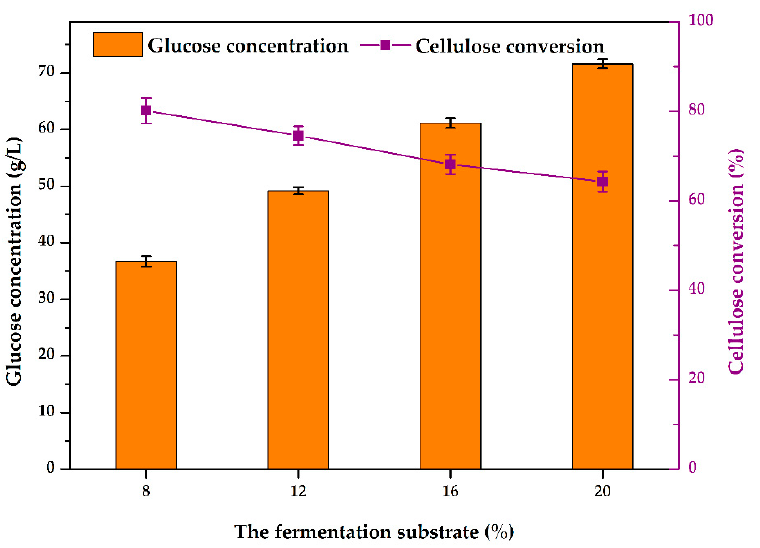
Figure 5. Comparison of enzymatic saccharification results with different substrate concentrations.